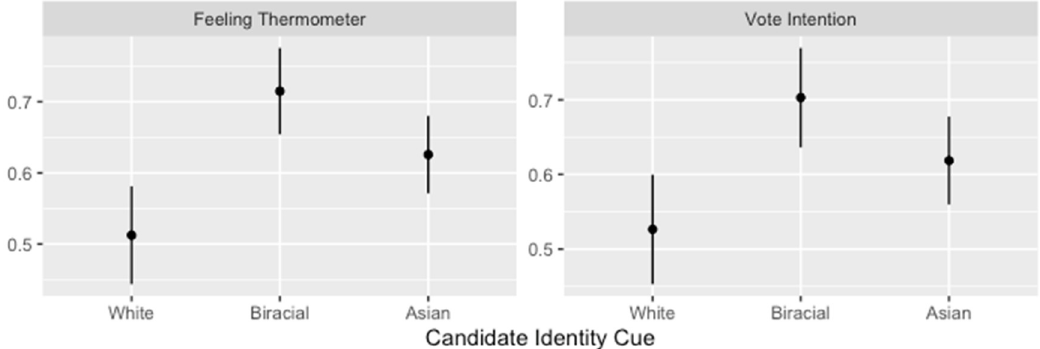
Figure 2. Mean feeling thermometer and vote intention ratings of hypothetical candidates from the Asian and White heritage treatment conditions. Sample includes only mixed-race participants who indicated two or more racial heritages among their parents. X -axis denotes different treatment groups based on the identity cued by our hypothetical candidates. Note: error bars denote 95% confidence intervals. Table 2. Results from difference-of-means t -tests for all possible treatment group comparisons in Figure 2.